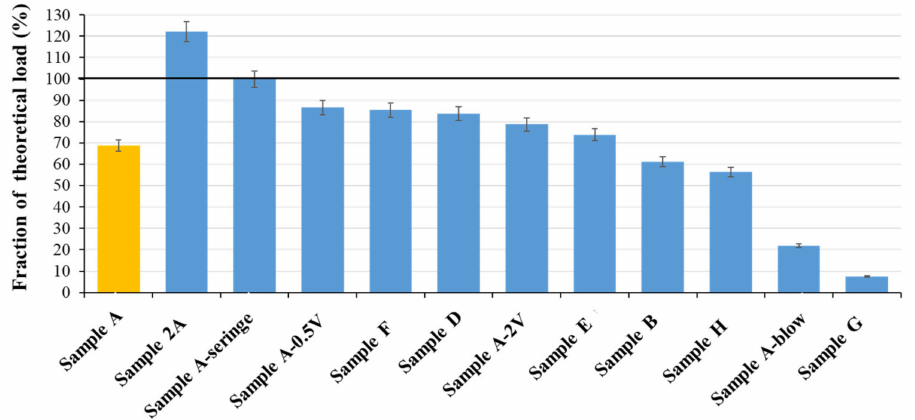
Figure 11. Diagram showing the actual load of coating compared to the theoretical load of coat- ing. The error intervals were estimated by taking into account the uncertainty about the monolith